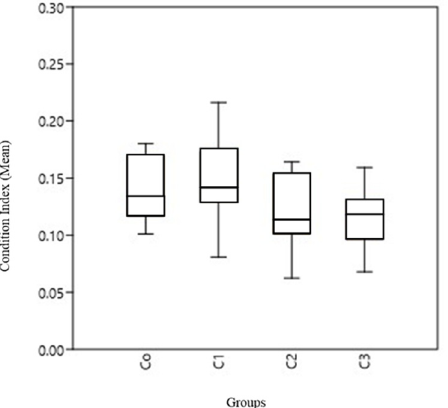
Figure 2. Boxplot for the condition indexes found in the different experimental groups.